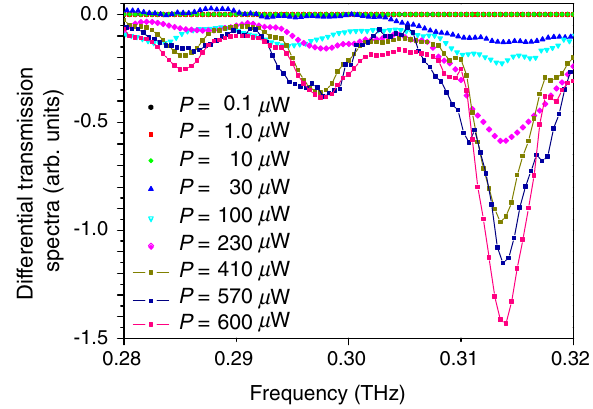
FIG. 7. Differential transmission spectra of the microwire- based absorption spectra obtained with different excitation power of the laser. The labeled BSA concentration is kept fixed at 1 mg = mL. The first three spectra are exactly